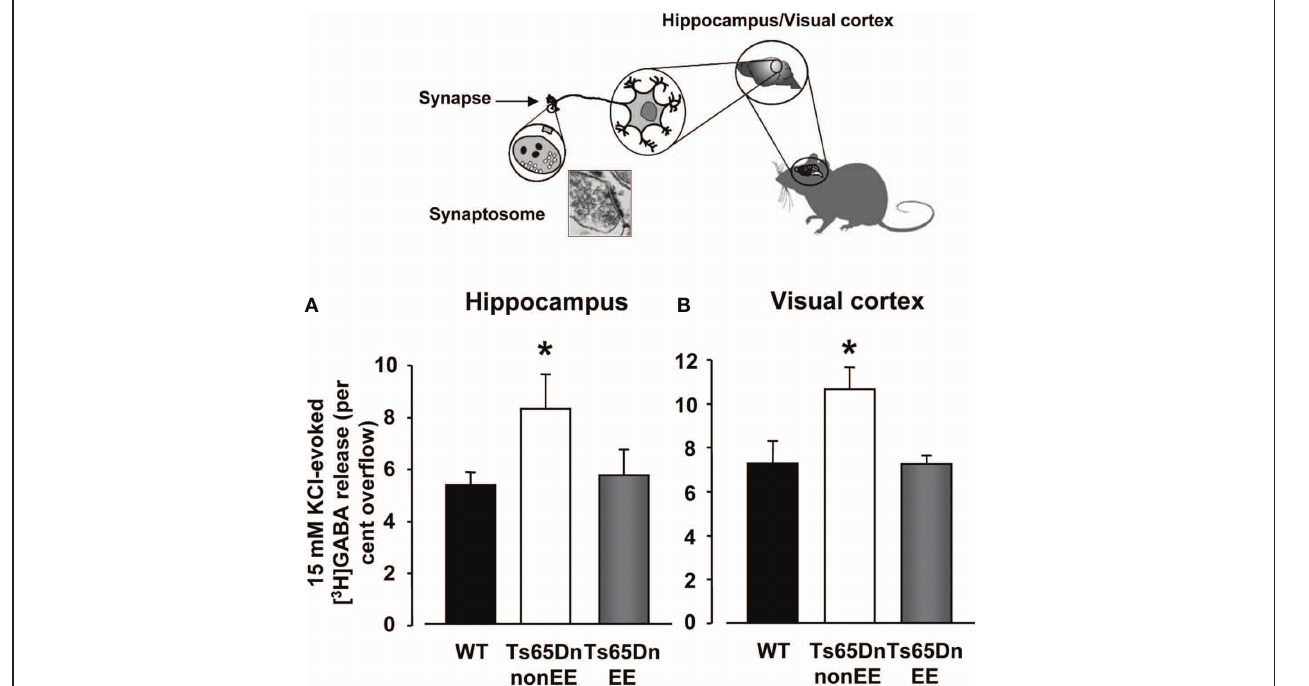
FIGURE 4 | Depolarization-evoked release of GABA from synaptosomes. Insert depicts the synaptosome technique. 15mM KCl evoked GABA release from hippocampal (A) and visual cortex (B) synaptosomes of wild-type (WT, black), Ts65Dn-non-EE (white) and Ts65Dn-EE (gray) mice. Two-Way ANOVA showed a significant difference among the different levels of group ( p = 0 . 001); a multiple comparison procedure (Holm–Sidak method)